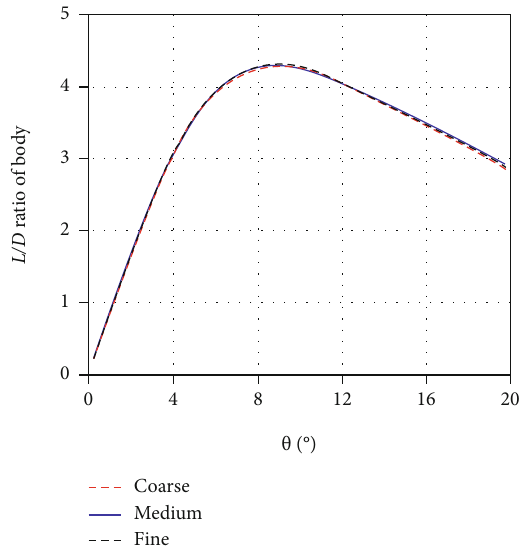
Figure 14: The L / D ratio of the body with di ff erent grids ( ω = 0 : 01 rad/s; depression